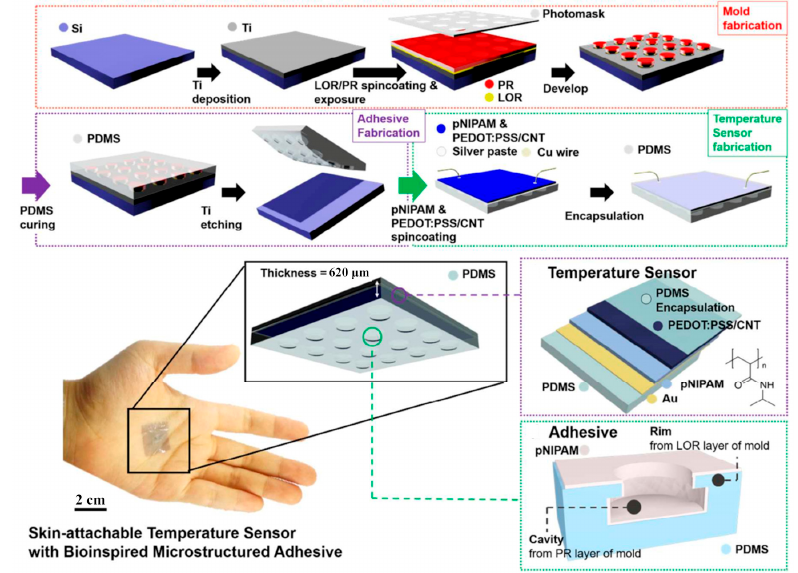
Figure 8. Fabrication process and the schematic illustration of PNIPAM hydrogel-based temperature sensor with the octopus-mimicking microstructured adhesive. Reprinted with permission from [114].